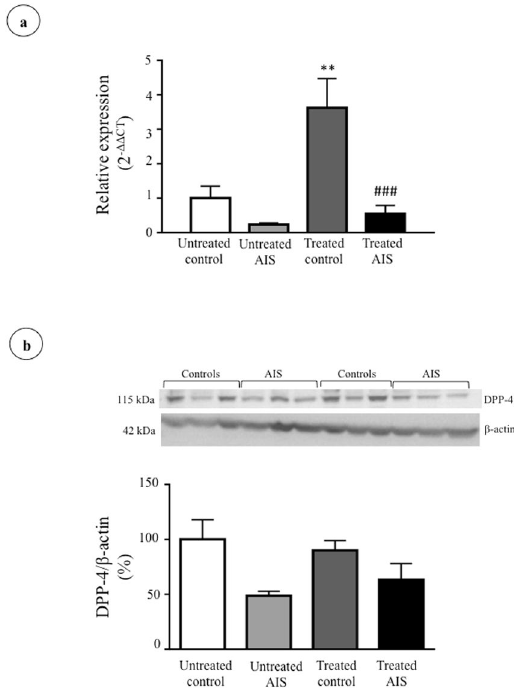
Figure 5. Impact of long-term treatment with GLP-1 on DPP-4 expression. Cells were treated with GLP-1 (10 mM) for 24 hours. ( a ) DPP4 gene expression was measured in osteoblasts of controls (n = 3) and AIS patients (n = 6) by RT-qPCR with GAPDH as endogenous control. Relative expression was analyzed with the 2 −ΔΔ CT method. ( b ) DPP-4 protein expression in osteoblasts of controls and AIS patients (n = 3/group) was measured by Western blot with β -actin as endogenous control. ** P < 0.01 vs. untreated controls; ### P < 0.001 vs. treated controls using one-way ANOVA followed by Tukey’s post-hoc tests. Data are presented as mean ± standard deviation.